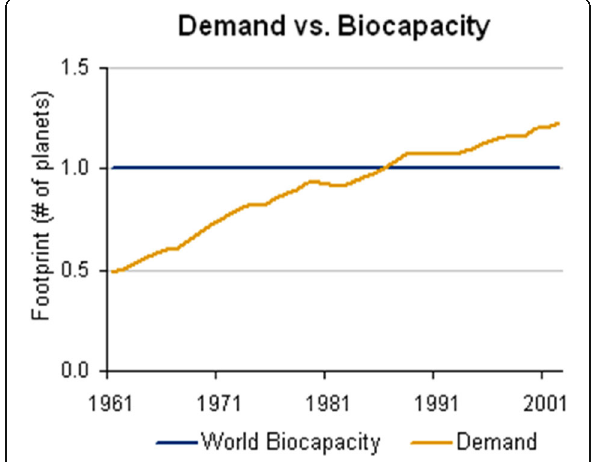
Fig. 2 Iconic graphical representation of demand versus bio- capacity from: Wackernagel et al., [38]This trend has only continued to grow in the interim, see: